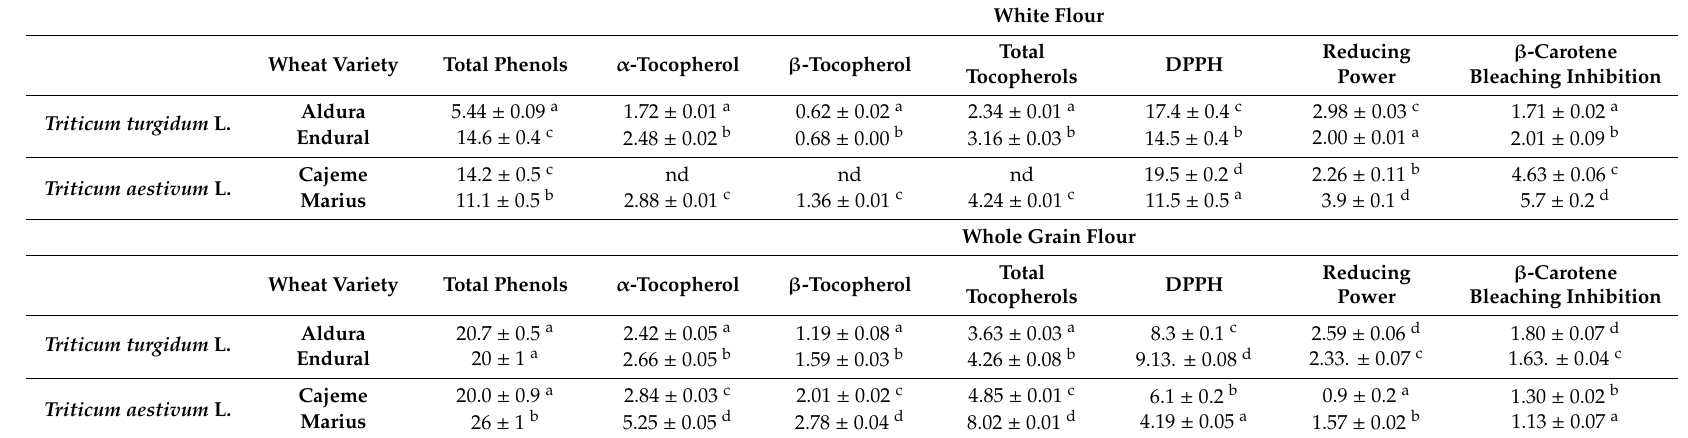
Table 2. Total phenols content (mg GAE / g extract), total tocopherol content ( µ g / g flour, dry weight) and antioxidant activity (EC 50 , mg / mL methanolic extract) of di ff erent bread and durum wheat flours (mean ±